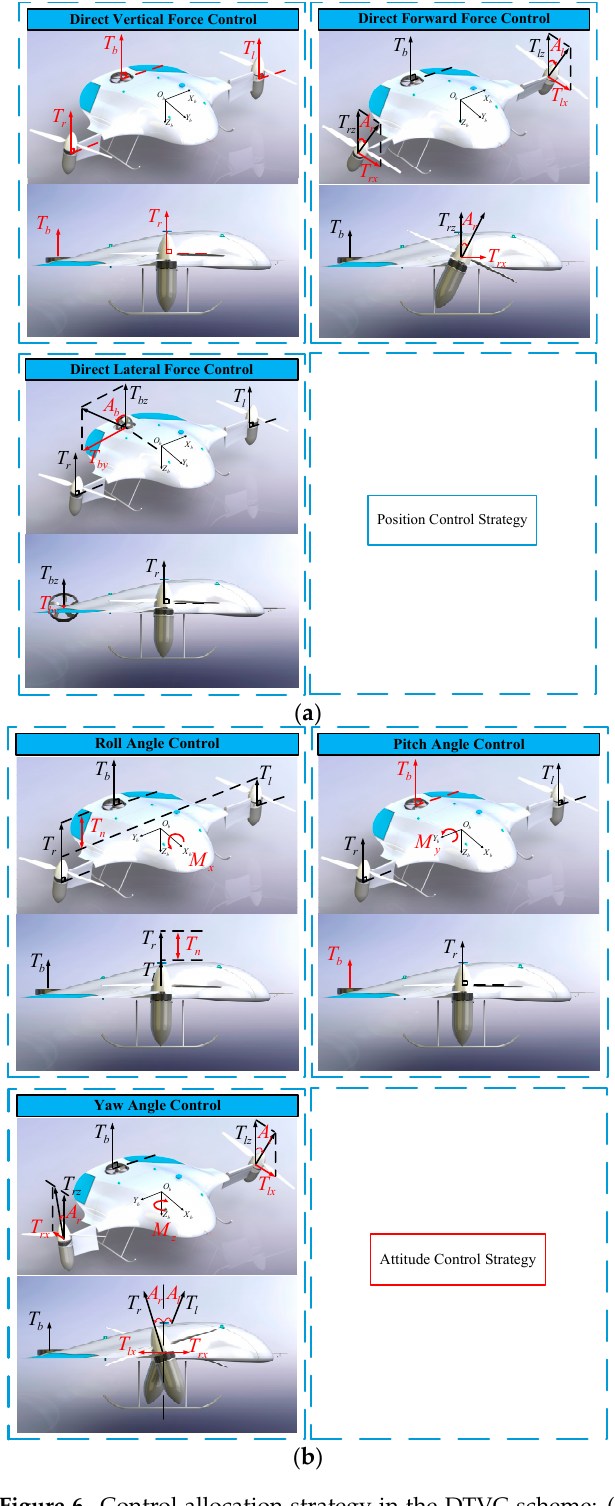
Figure 6. Control allocation strategy in the DTVC scheme: ( a ) control allocation strategy for the position channel; ( b ) control allocation strategy for the attitude